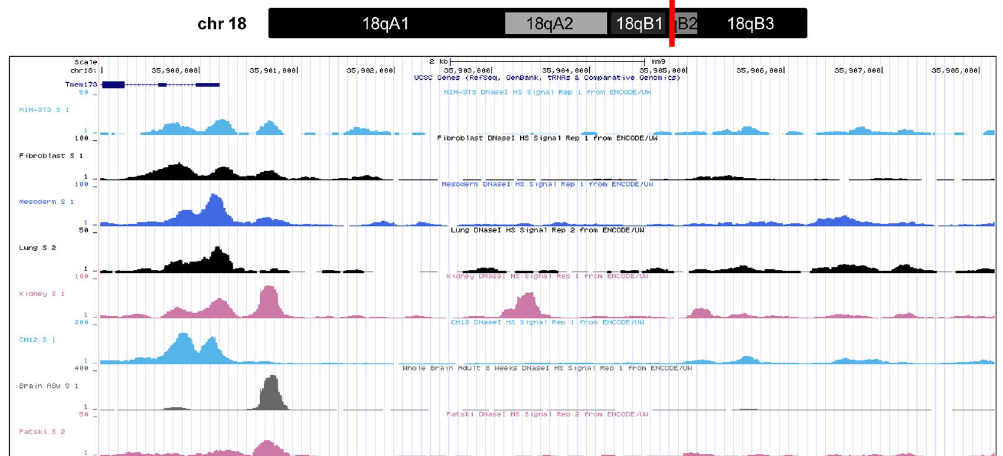
Figure 1. DNase I hypersensitive sites in 5 ′ upstream of the mSTING gene by ENCODE. Part of the chromosome 18 structure was shown on the top of diagram and the mSTING gene (NC_000084.6) location was marked by red line. The 5 ′ -flanking region of the mSTING gene (chr18:35, 899, 540–35, 904, 129, 4590 nt) was analyzed for DNase I hypersensitive sites in several murine cell lines and tissues including NIH3T3 cells by ENCODE (http://genome.ucsc.edu/). As the bottom of figure shown by UCSC Genome Browser on Mouse July 2007 (NCBI37/mm9) Assembly, the peaks of DHS appeared around TSS of the mSTING